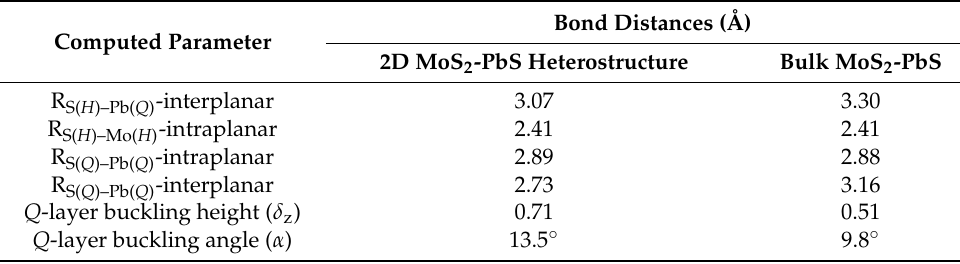
Table 1. Calculated bond distances (in Å) and buckling parameters of the 2D MoS 2 -PbS heterostruc- ture consisting of a MoS 2 monolayer ( H ) and a PbS bilayer ( Q ). The corresponding values of the bulk MoS 2 -PbS material are also